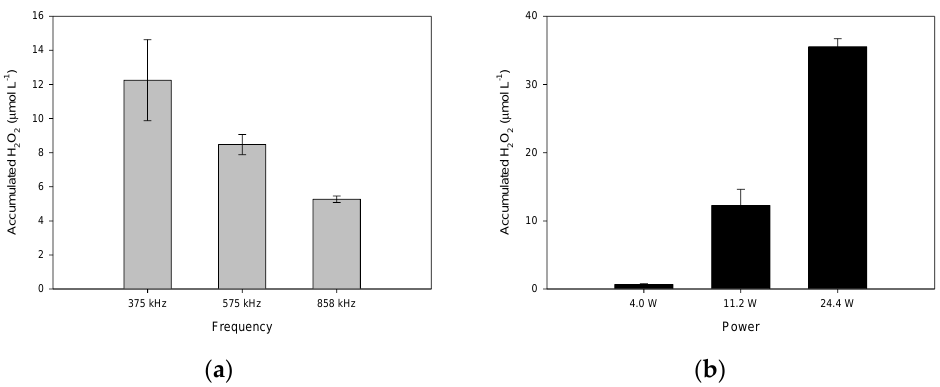
Figure 1. Capability of the ultrasound reactor to produce H 2 O 2 in distilled water at 20 min of sonication. ( a ) Effect of the ultrasound frequency (V: 250 mL, P: 11.2 W); ( b ) Effect of ultrasound power (V: 250 mL, f: 375 kHz).